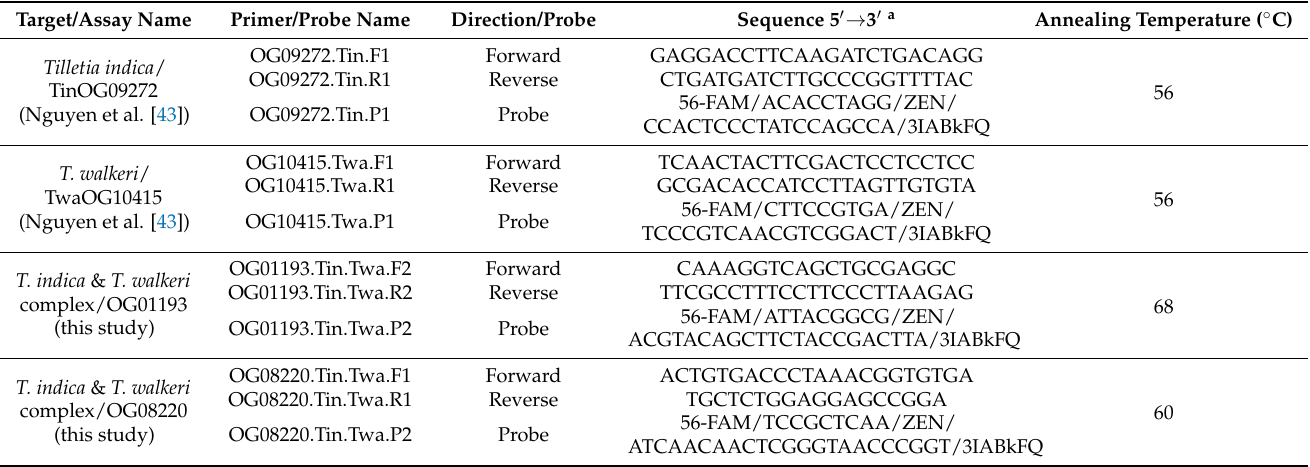
Table 4. Tilletia qPCR assay primers and probes, annealing temperatures and limit of